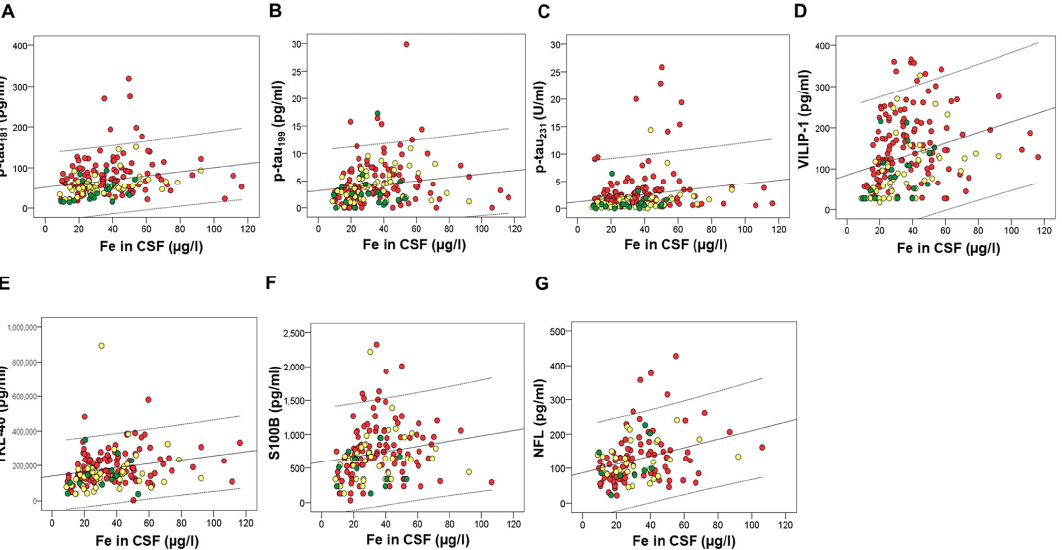
Figure 3. Correlation of CSF biomarkers of AD – p ‐ tau 181 ( A ), ptau 199 ( B ), ptau 231 ( C ), VILIP ‐ 1 ( D ), YKL ‐ 40 ( E ), S100B ( F ), and NFL ( G ) with Cu measured in CSF. Red circles represent AD patients, yellow circles represent MCI patients, while green circles represent healthy controls.